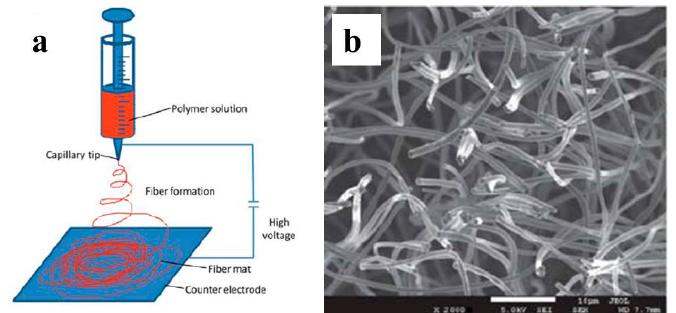
Figure 6. ( a ) Schematic of electrospunning setup; ( b ) SEM image of 3D porous carbon fiber mats fabricated by electrospun, the bar is 10 μ m [97]. Reproduced with permission from the Royal Society of Chemistry.